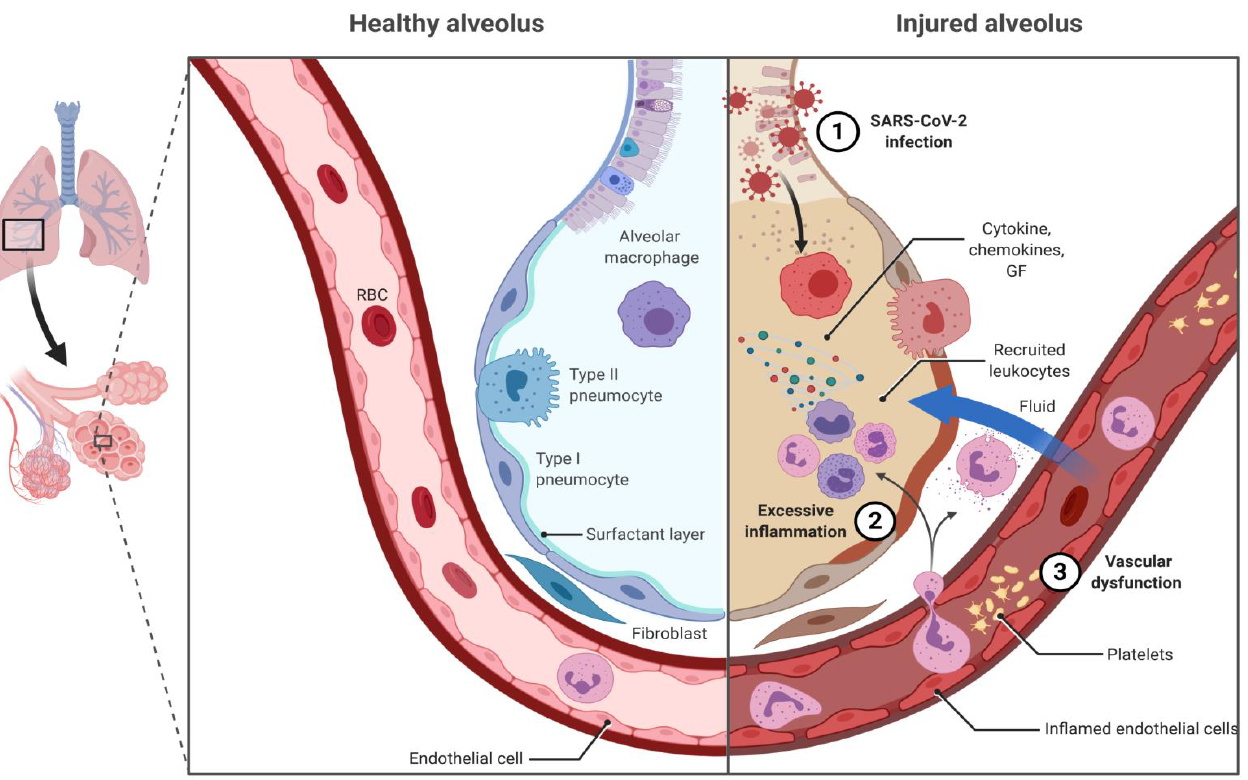
Figure 1. This figure compares the alveolar immune responses in healthy and injured lung after SARS-CoV-2 infection. ( 1 ) Coronavirus infects lung cells and encounter alveolar macrophages. ( 2 ) Alveolar macrophages identify the virus and initiate innate and acquire immune responses. Cytokines, chemokines or growth factors will attract additional immune responses, which will amplify and perpetuate the inflammation, damaging lung alveoli and endothelium. ( 3 ) Endothelium/platelet activation and increased vascular permeability will ultimately provoke vascular dysfunction, allowing virus dissemination and boost leukocytes infiltration.